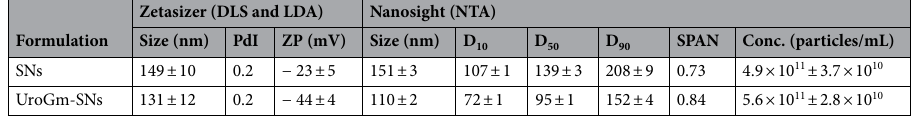
Table 1. Physicochemical characterization of SNs and UroGm-SNs. nm: nanometer, PdI: polydispersity index, ZP: zeta potential in millivolts (mV), UroGm: Uroguanylin derivative.